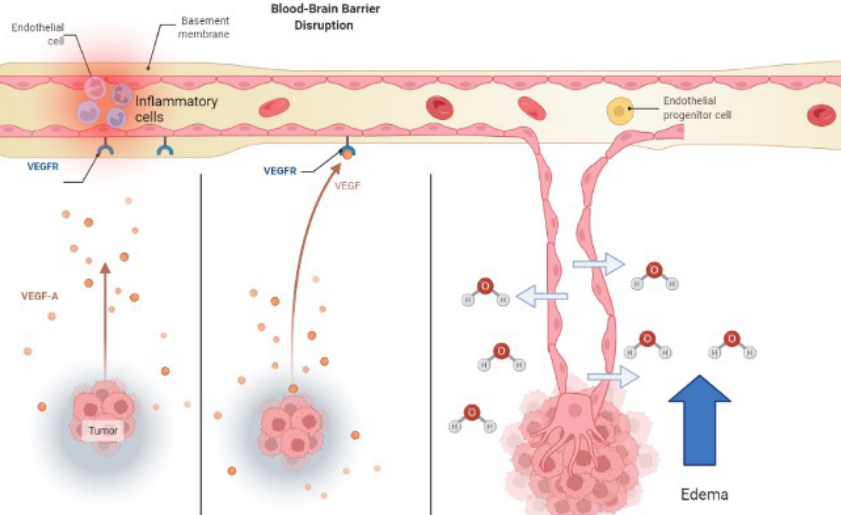
Figure 2. How angiogenic signaling molecules cause new faulty vessels to develop. New vessels are highly permeable to fluid and extravasation contributes to vasogenic edema. VEGFR: VEGF receptor; VEGF-A: VEGF factor